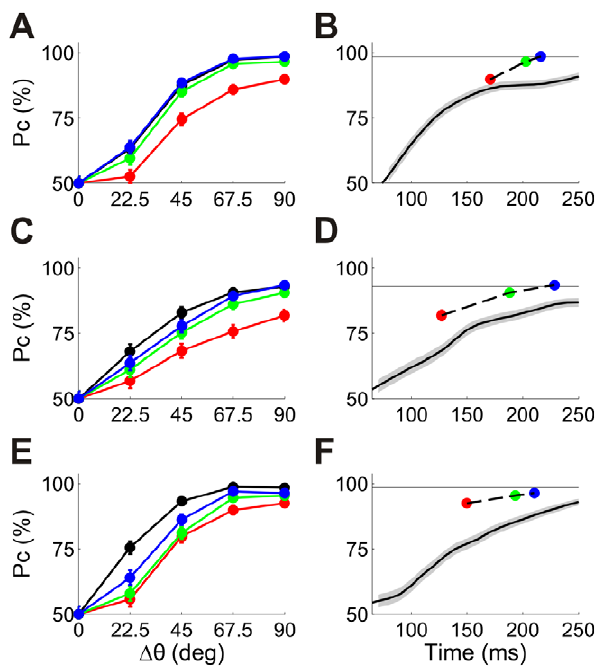
Figure 5. Orientation discrimination using single cell spike latencies and firing rates. (A) Neurometric curves for a single cell using the first spike latency (red), second spike latency (green), third spike latency (blue) and the firing rate (black). These curves represent the probability of correct discrimination in a 2AFC paradigm where one stimulus is at the cell’s preferred orientation, PO, and the other at PO 6 Dh . (Error bars represent the standard error of the mean, but are often smaller than the marker size). (B) Neurometric curves for 90 u discrimination as a function of decision time. The black curve represents probability of correct discrimination based on firing rate for different time windows starting at stimulus onset (the curve starts at 60 ms because deviation from spontaneous activity starts at about this time). (The gray band represents 6 standard error of the mean). The horizontal line represents the asymptotic performance using firing rate from the full response (black circle at 90 u in A). The filled circles represent decisions using first, second and third spike latencies with the same color code as in (A) (error bars are smaller than the marker size). Each circle is plotted at the corresponding mean decision time. This cell was taken from dataset 1 in Table 1. (C)–(F) The same as (A) and (B) for two other cells from dataset 5 in Table 1. (The 3 cells in this figure are the same cells as in Figure 2).